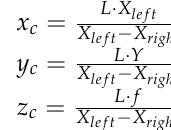
where the baseline distance L is the distance between the projection center lines of the two cameras, and, since the two camera imaging planes are in the same plane, Y left = Y left = Y . On the basis of the principle of flat binocular stereo vision 3D measurement, the more general case is considered, i.e., there is no requirement for the position of the two cameras. As shown in Figure 3, let the left camera coordinate system O l − x l y l z l coincide with the world coordinate system O − xyz , the coordinates of the space point P are ( x p , y p , z p ) , and the image coordinate system is O 1 − x 1 y 1 ; the right camera coordinate system is O r − x r y r z r , and the image coordinate system is O r − x r y r . From the projective transformation, we have